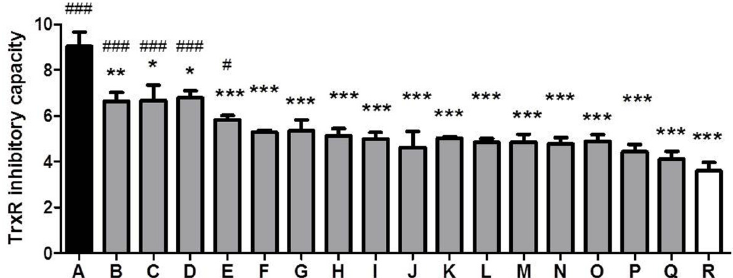
Figure 4. Comparison of thioredoxin reductase (TrxR) inhibitory capacity of different cigarette brands. Data are presented as means ± SEM ( n = 3). Compared to brand A, * p < 0.05; ** p < 0.01; *** p < 0.001. Compared to brand R, # p < 0.05; ### p < 0.001.